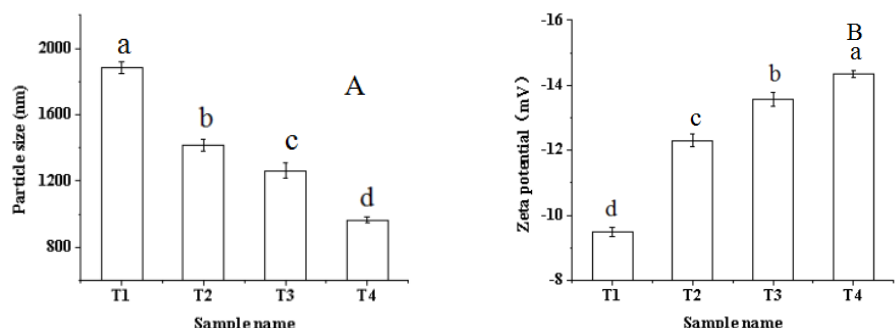
Figure 3. Effects of ultrasound-assisted sodium bicarbonate treatment on the particle size ( A ) and Zeta potential ( B ) of raw pork myofibrillar protein. T1, sodium bicarbonate 0 g, ultrasound time 0 min; T2, sodium bicarbonate 0.2 g, ultrasound time 0 min; T3, sodium bicarbonate 0.2 g, ultrasound time 30 min; T4, sodium bicarbonate 0.2 g, ultrasound time 60 min. Each value represents the mean ± SE, n = 4. a–d Different parameter superscripts indicate significant differences ( p < 0.05).